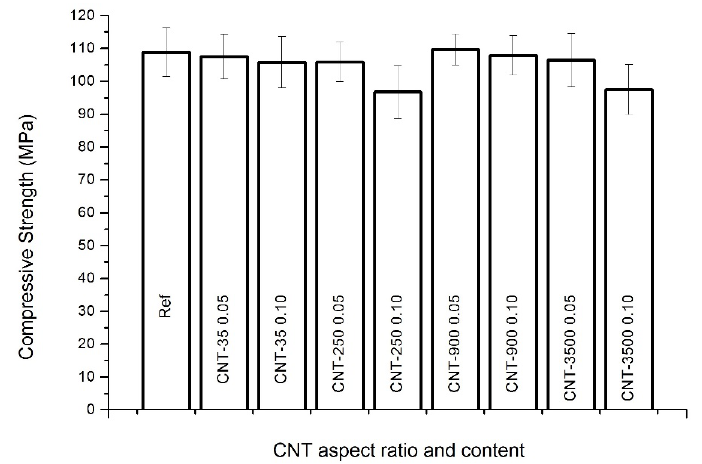
Figure 3. Compressive strength of the pastes at 28 days.